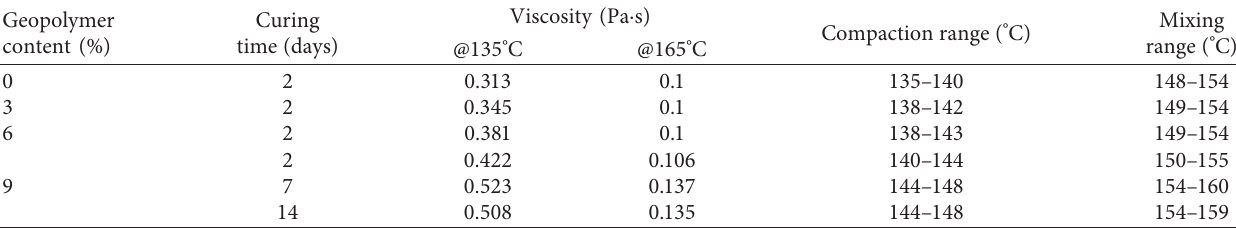
Table 3: Geopolymer effects on compaction and mixing